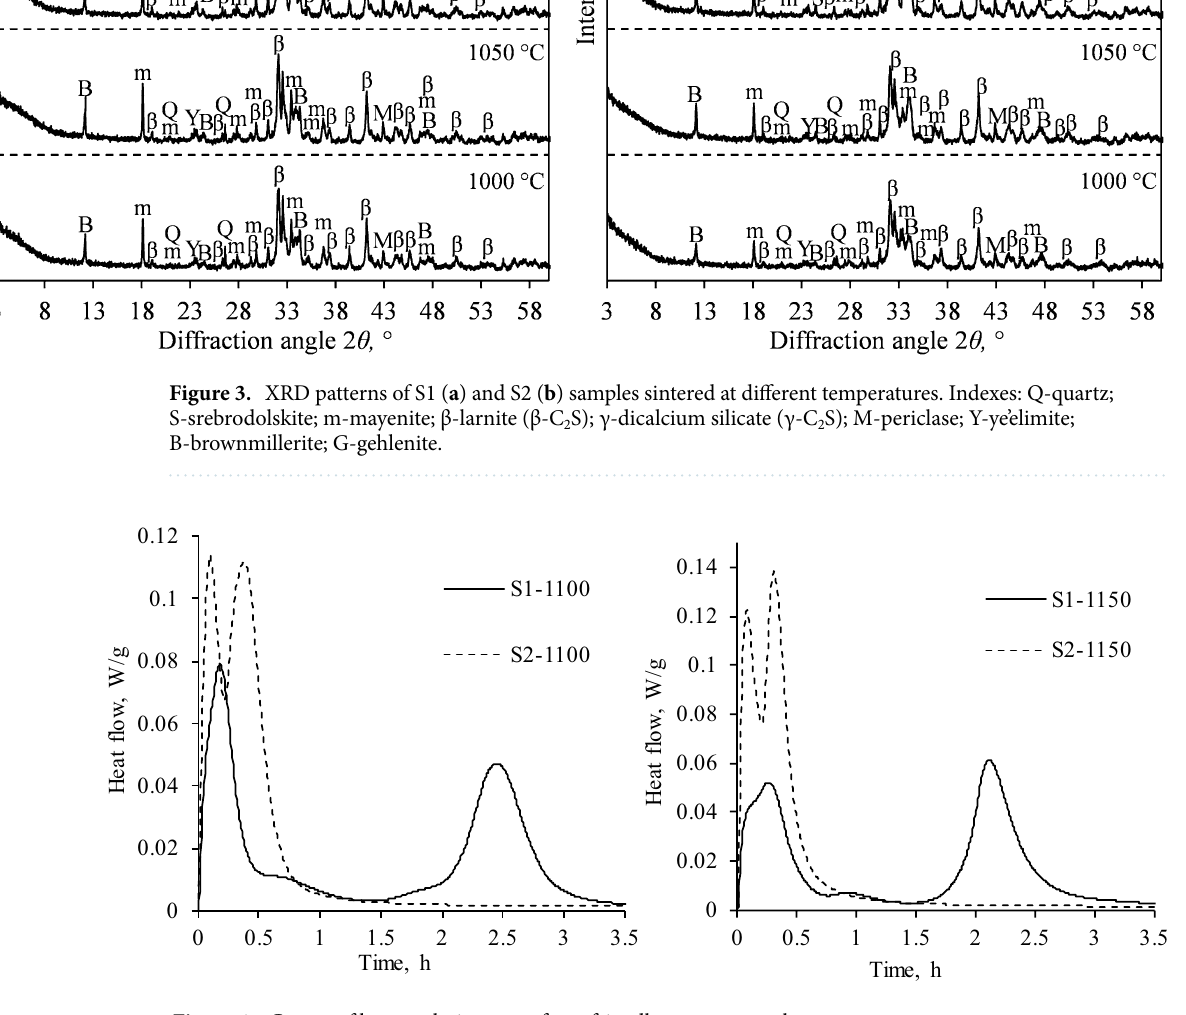
Figure 4. Curves of heat evolution rate of eco-friendly cement